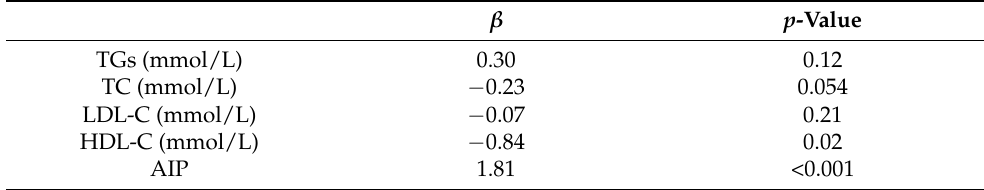
Table 3. The relationship between lipidic fractions and OSA in subjects not taking statins. β p -Value TGs (mmol/L) 0.30 0.12 TC (mmol/L) − 0.23 0.054 LDL-C (mmol/L) − 0.07 0.21 HDL-C (mmol/L) − 0.84 0.02 AIP 1.81 <0.001